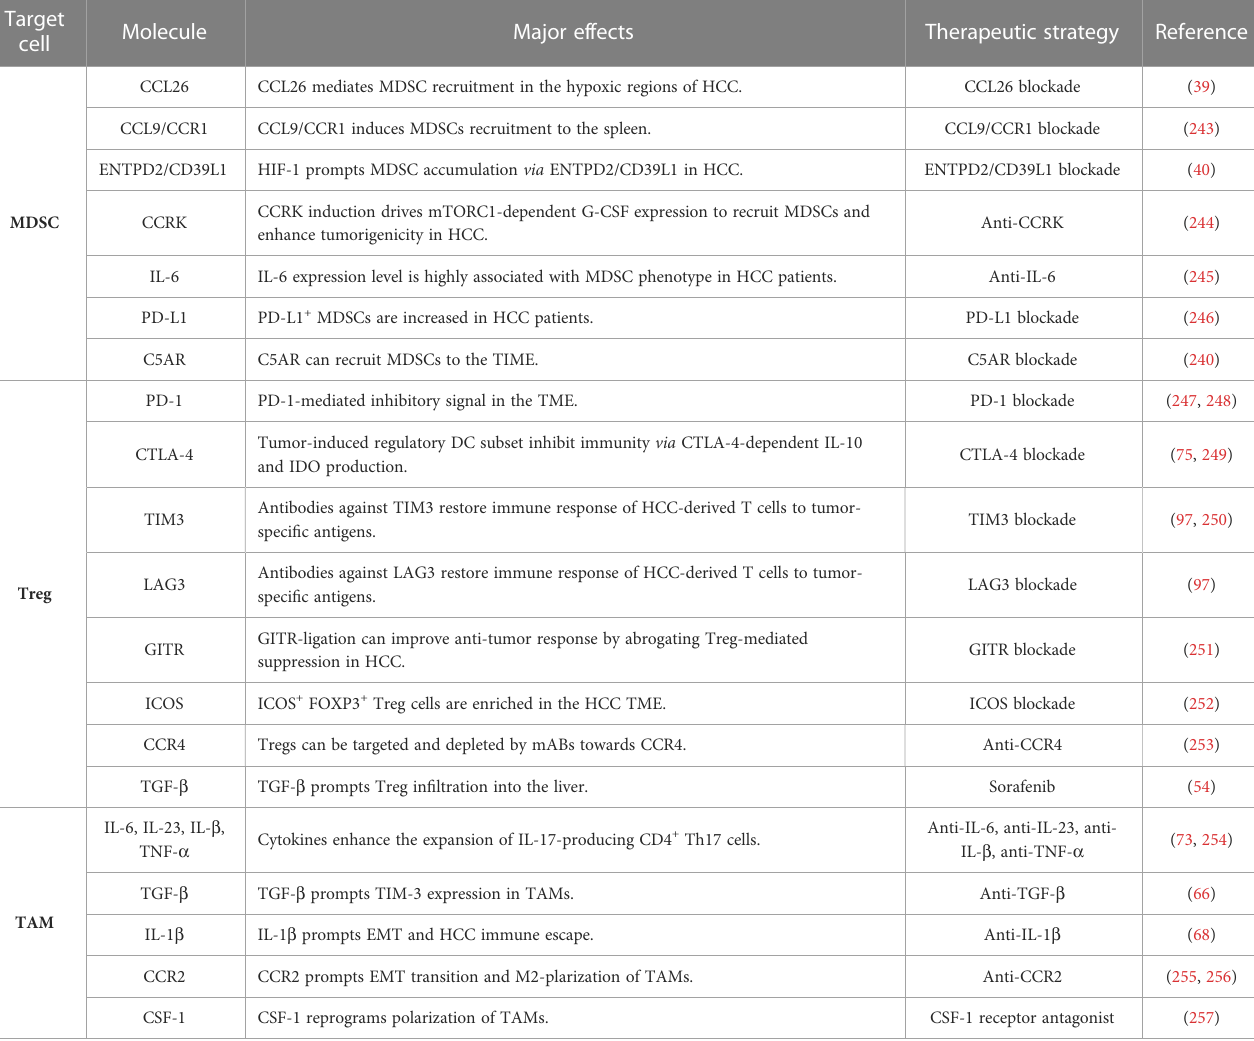
TABLE 3 A summary of molecular targets in the tumor immune microenvironment of HCC. Target